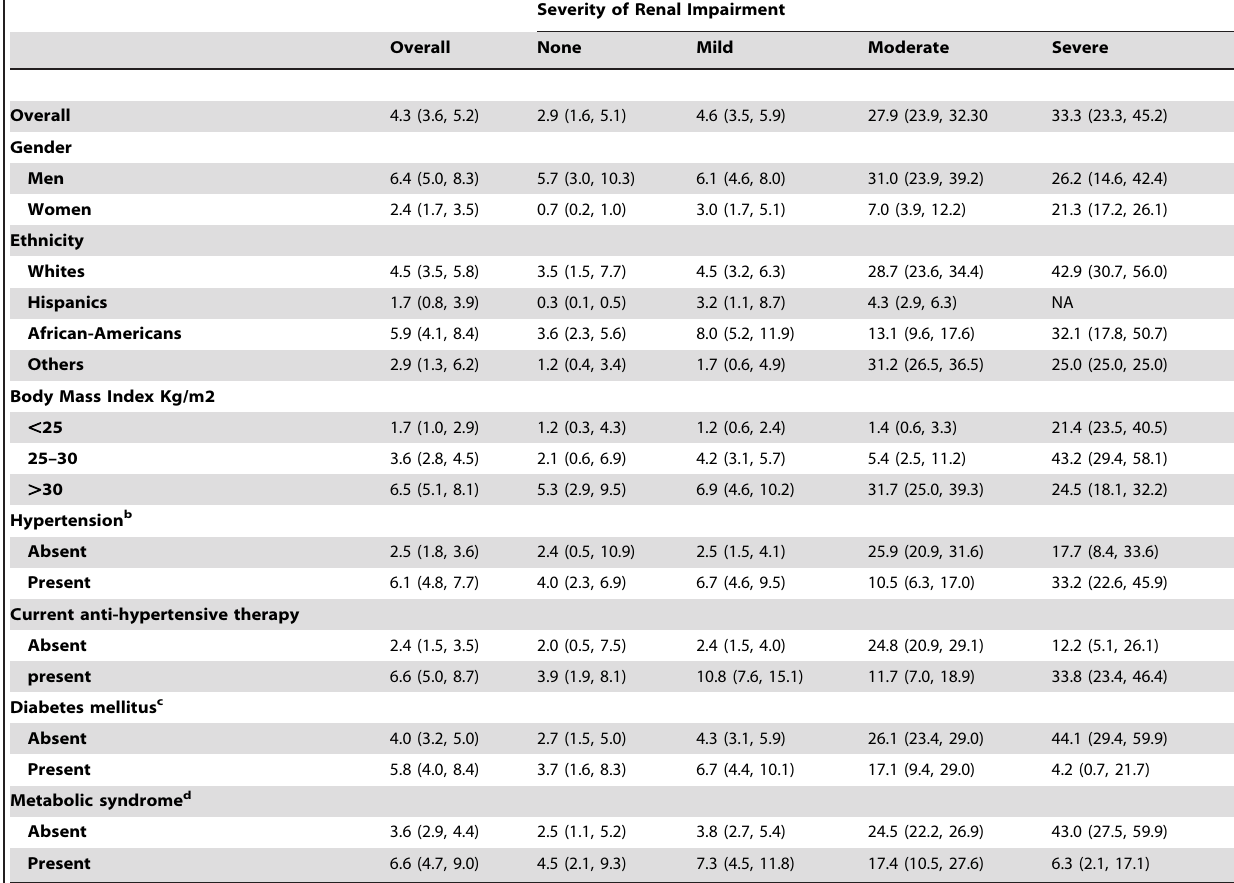
Table 4. Age-standardized prevalence (%) of gout by renal glomerular function.